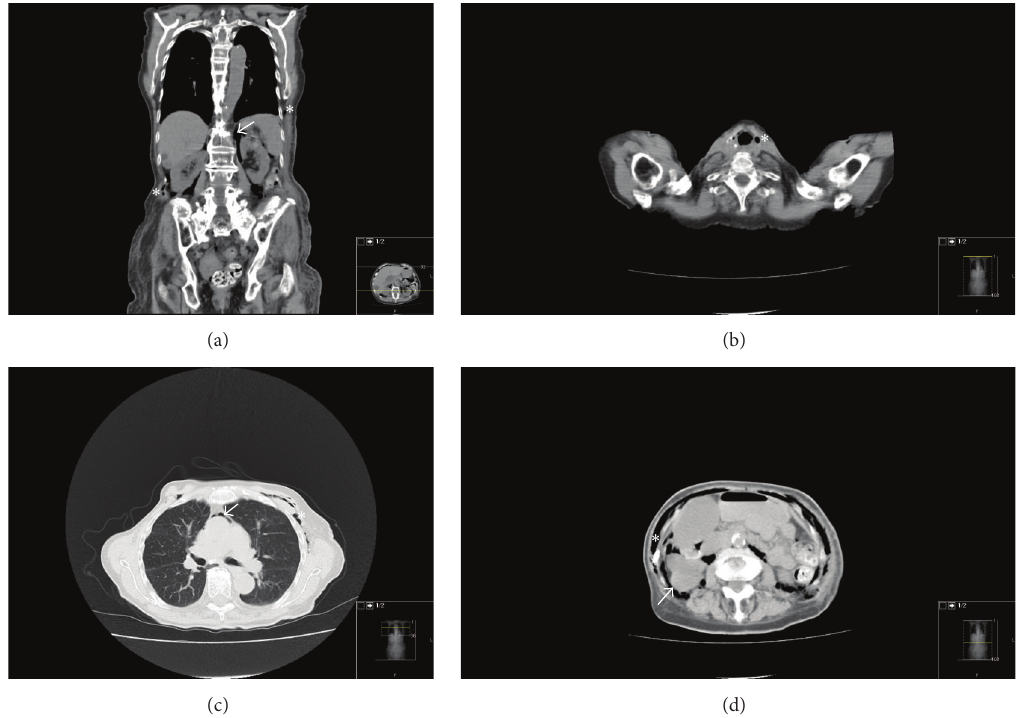
Figure 1: (a) Thoracic and abdominal (asterisk) subcutaneous emphysema and retroperitoneal gas (arrow). (b) Cervical subcutaneous emphysema (asterisk). (c) Thoracic subcutaneous emphysema (asterisk) and pneumomediastinum (arrow). (d) Abdominal subcutaneous emphysema (asterisk) and retroperitoneal gas